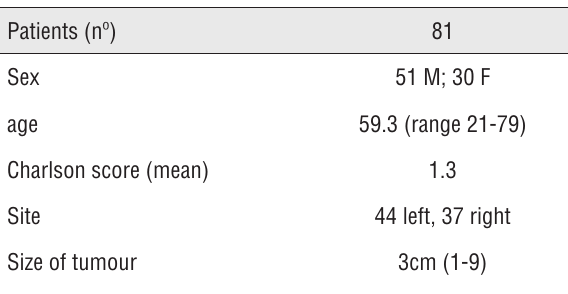
Table 1 - Patients